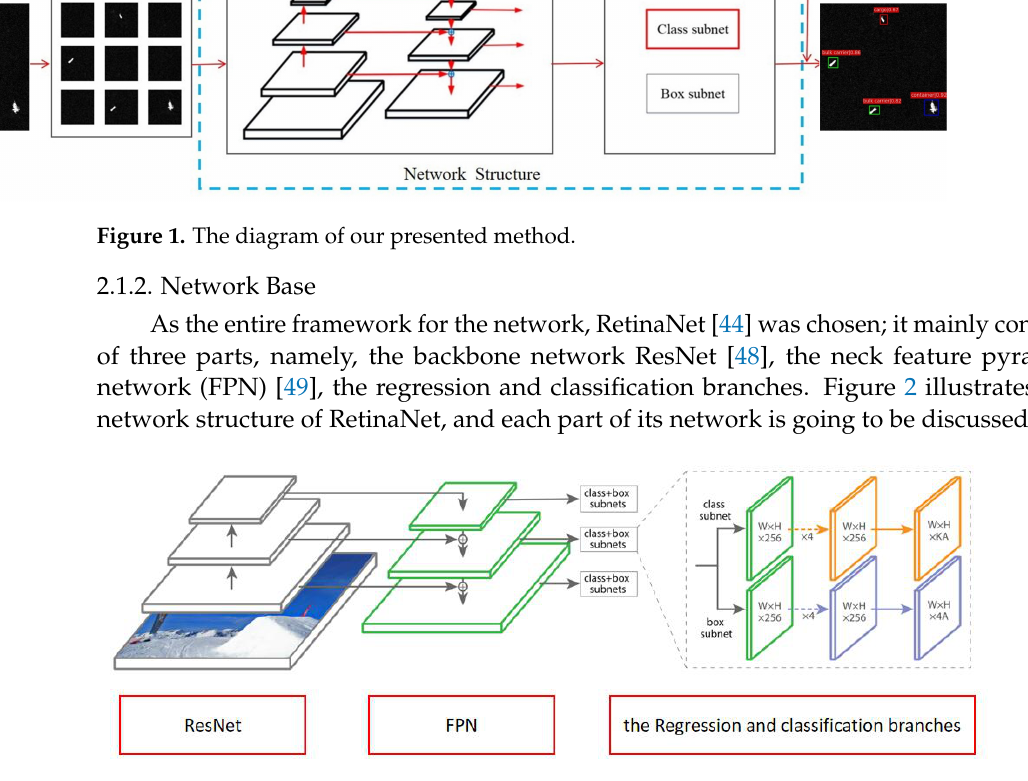
Figure 2. A diagram of RetinaNet’s network